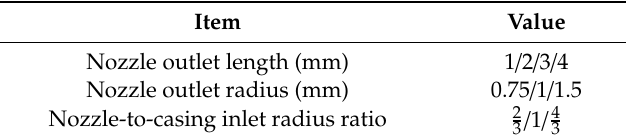
Table 2. Numerical simulation scheme.